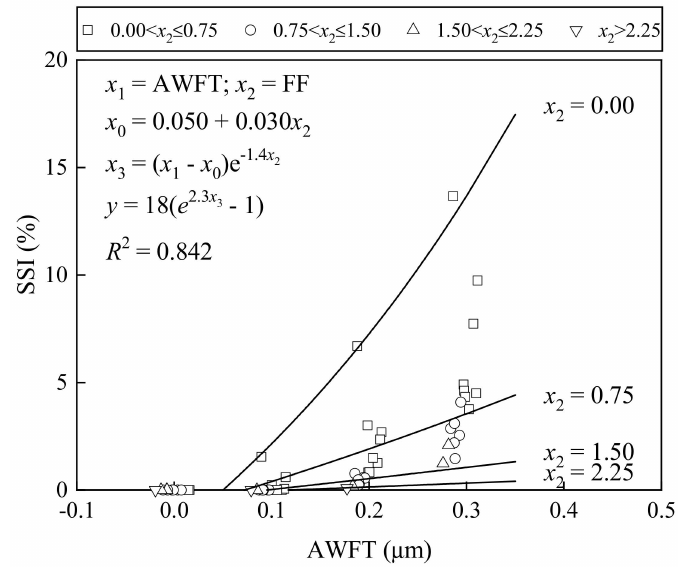
Figure 8. Correlation of SSI with AWFT and FF.